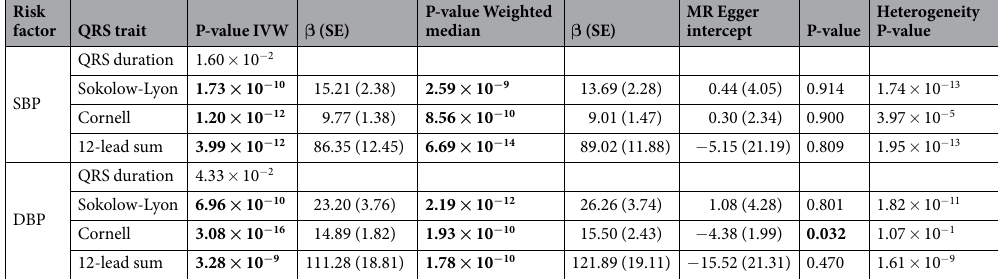
Table 1. Mendelian Randomization analyses of cardiovascular risk factors and QRS traits. β = beta